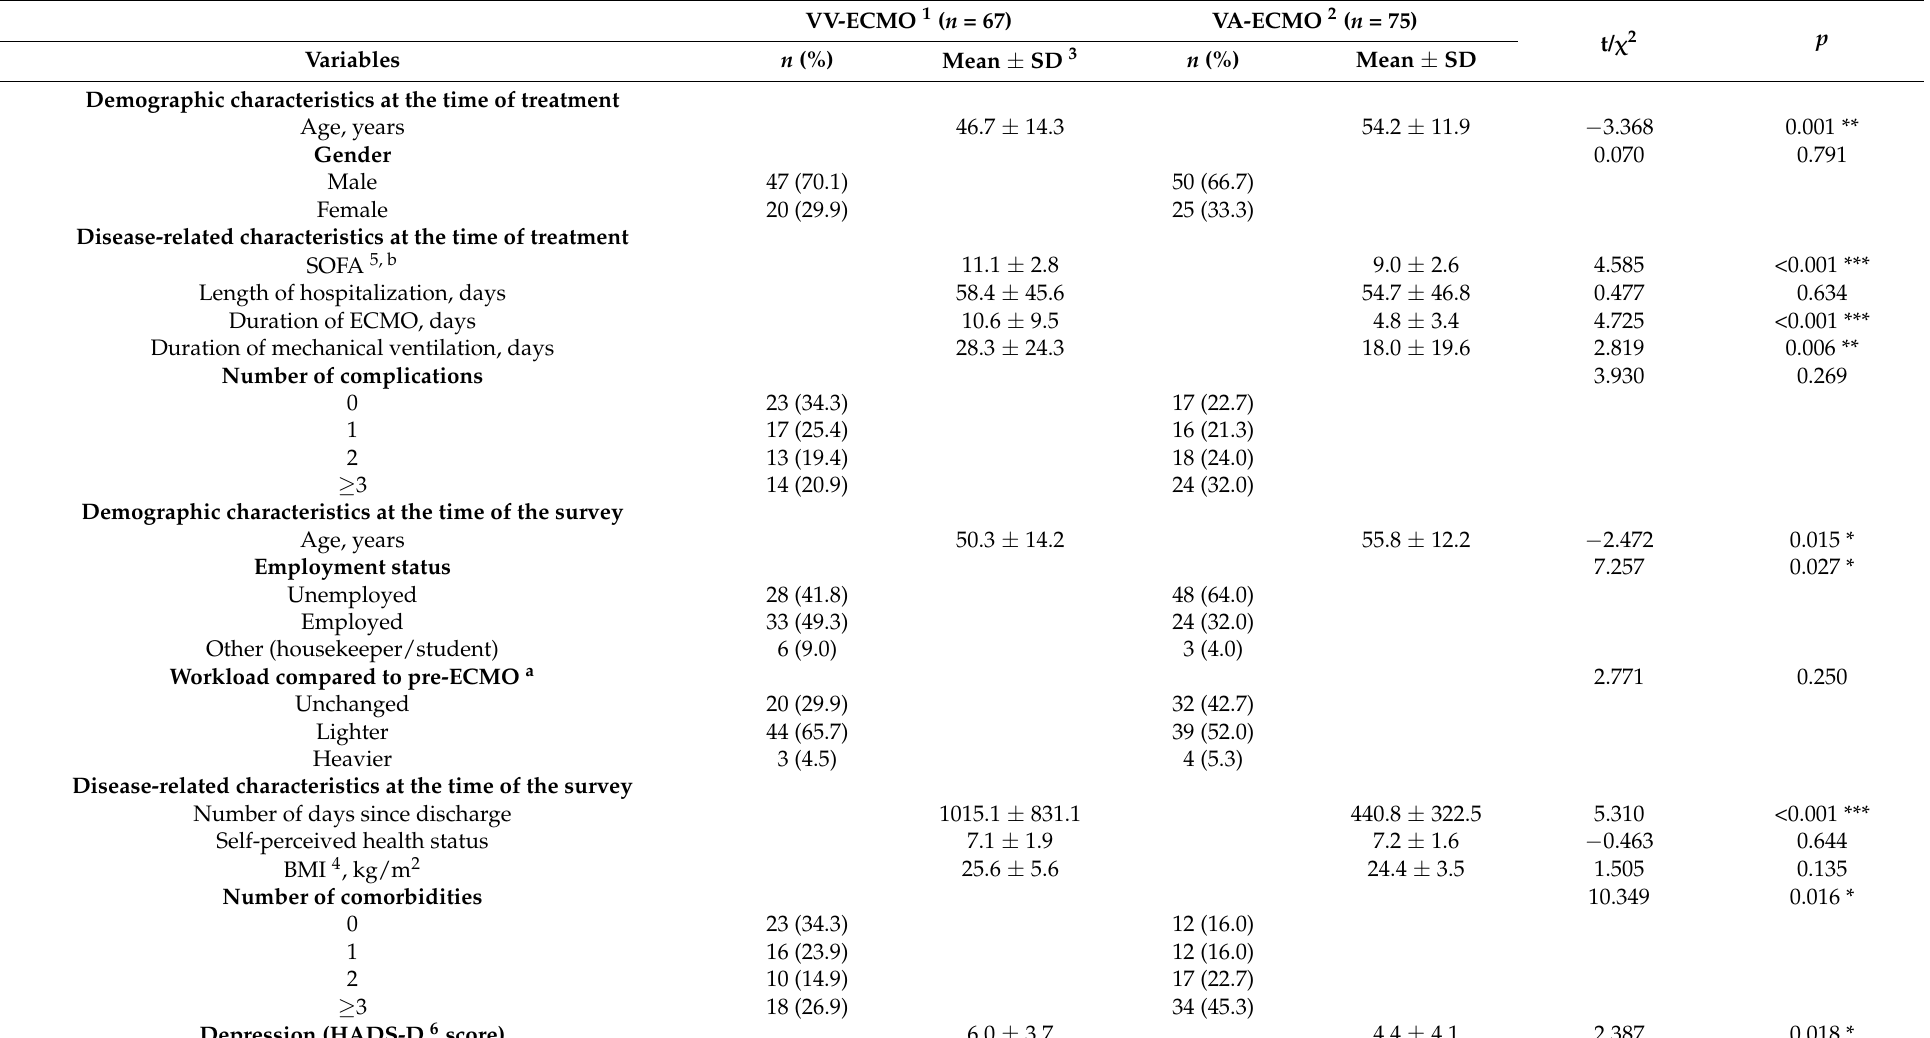
Table 1. Differences in characteristics of participants receiving veno-venous (VV) or veno-arterial (VA) extracorporeal life support